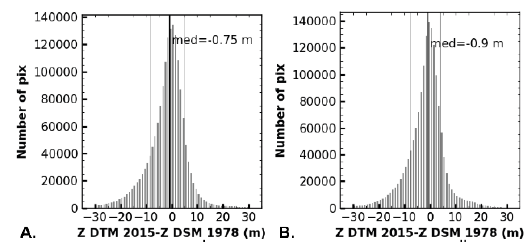
Figure 8. Histograms of elevation differences between photogrammetric 1978 elevation (A. low elevation flight and B. high elevation flight) with lidar of 2015 DTM at 5 m resolution. The median and the 17% and 83% quantiles are represented by the black and grey vertical lines respectively: [-8.52 m; 4.84 m] low and [-7.89 m; 4.0 m] high elevations.